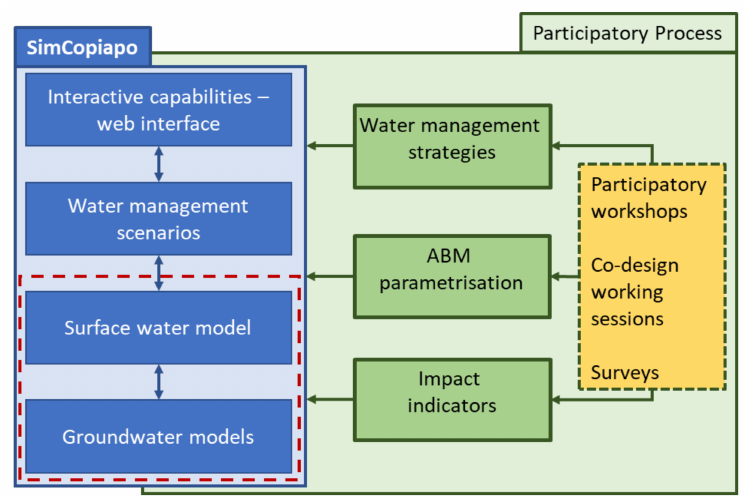
Figure 2. General methodological framework highlighting development of the digital platform SimCopiapo, participatory processes and the integration of the surface water and groundwater models (red dashed